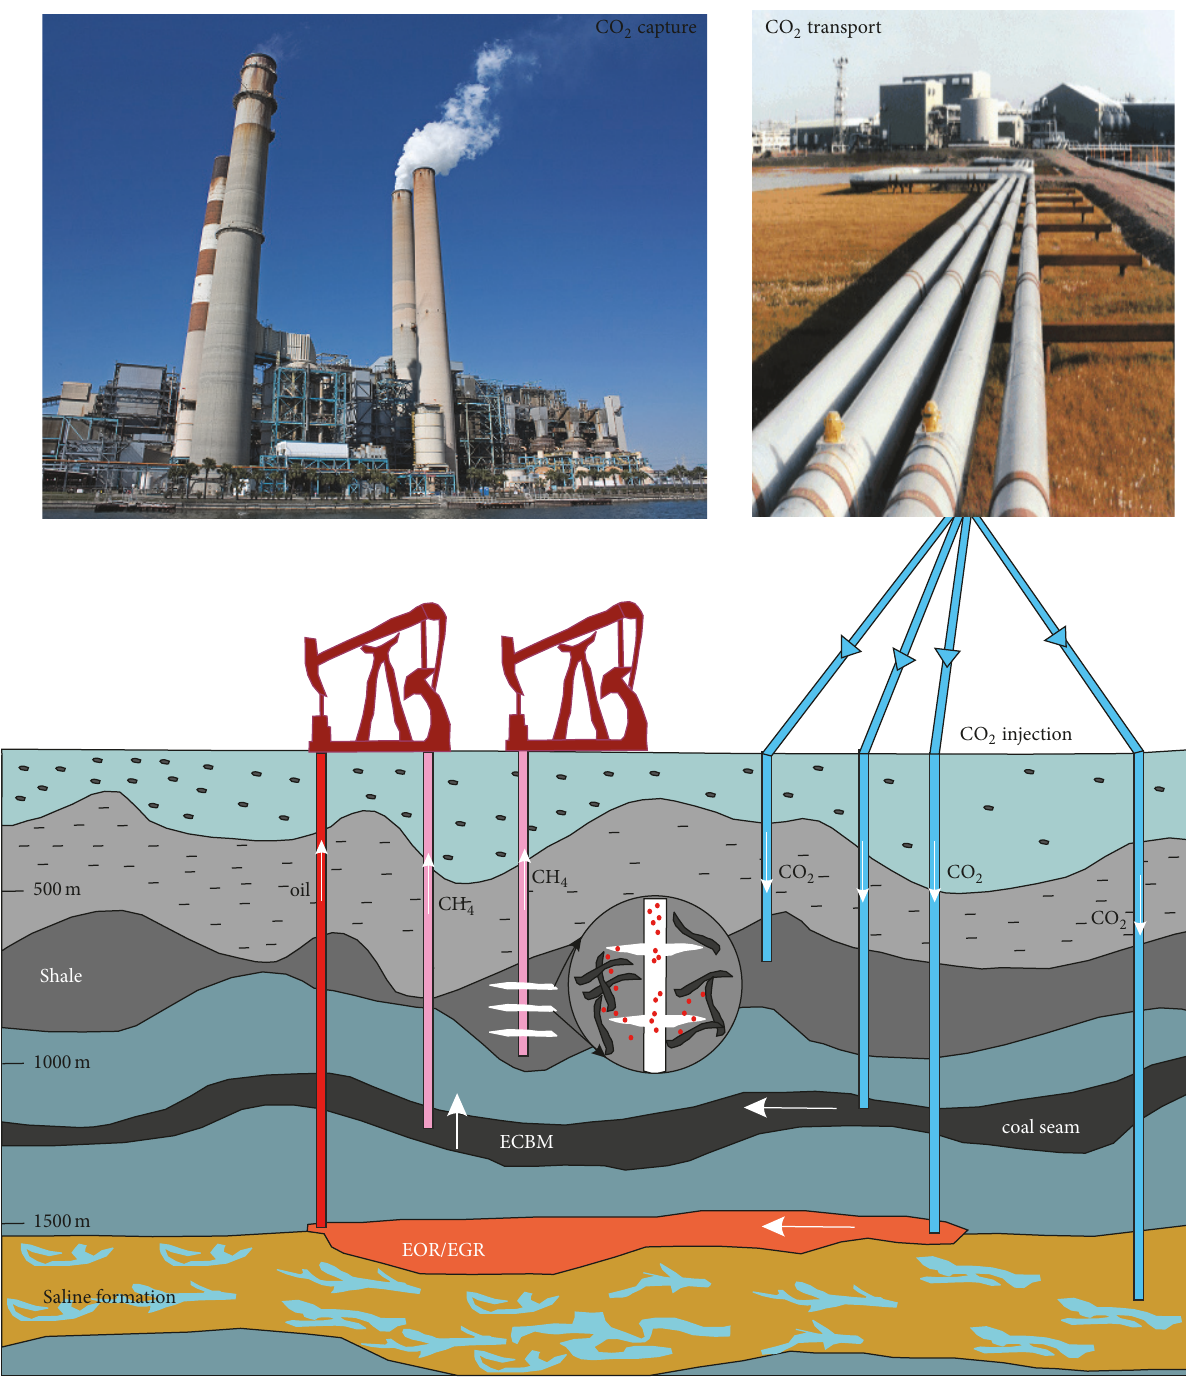
Figure 1: Schematic diagram of the CCUS technology in different geological reservoirs for both long and short-term sequestration of CO 2 .